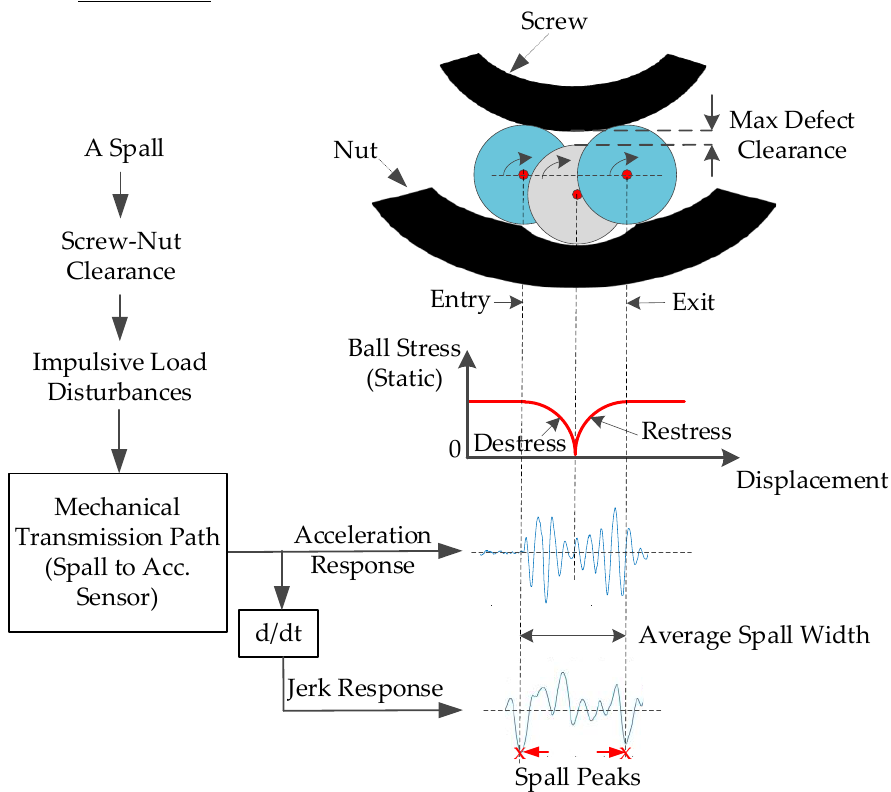
Figure 2. Illustration of a ball-screw mechanism within an EMA and the acceleration sensor mounted on the nut.